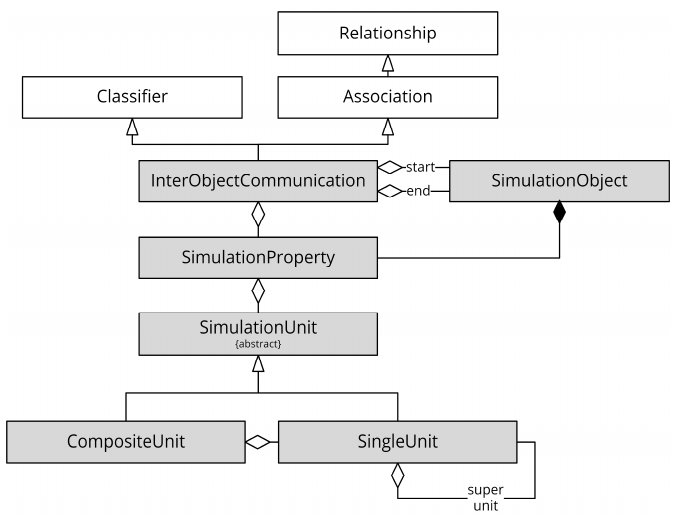
Figure 20. Simplified view on the introduced InterObjectCommunication meta-class that inherits from classifier and association inspired by the UML-owned meta-class AssociationClass . Additionally, the structure of the meta-class SimulationUnit is shown, which represents the unit of a value of a SimulationProperty (cf. Figure 18). White boxes represent existing UML metamodel elements and gray boxes represent newly added